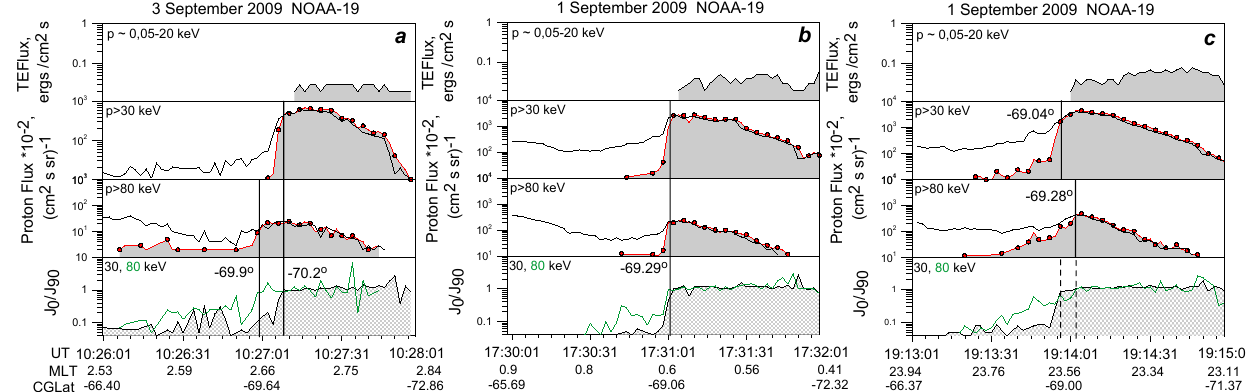
Figure 4. Examples of standard-type dispersion (a) , no IB dispersion (b) , and anomalous dispersion (c) .